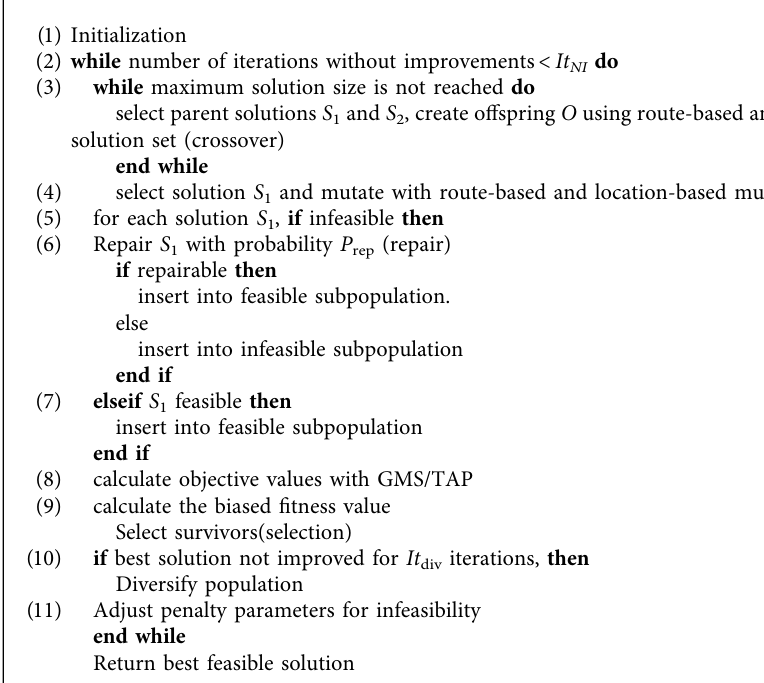
in Figure 4. Te link impedance functions of the road links and bus links were BPR (Bureau of public road)